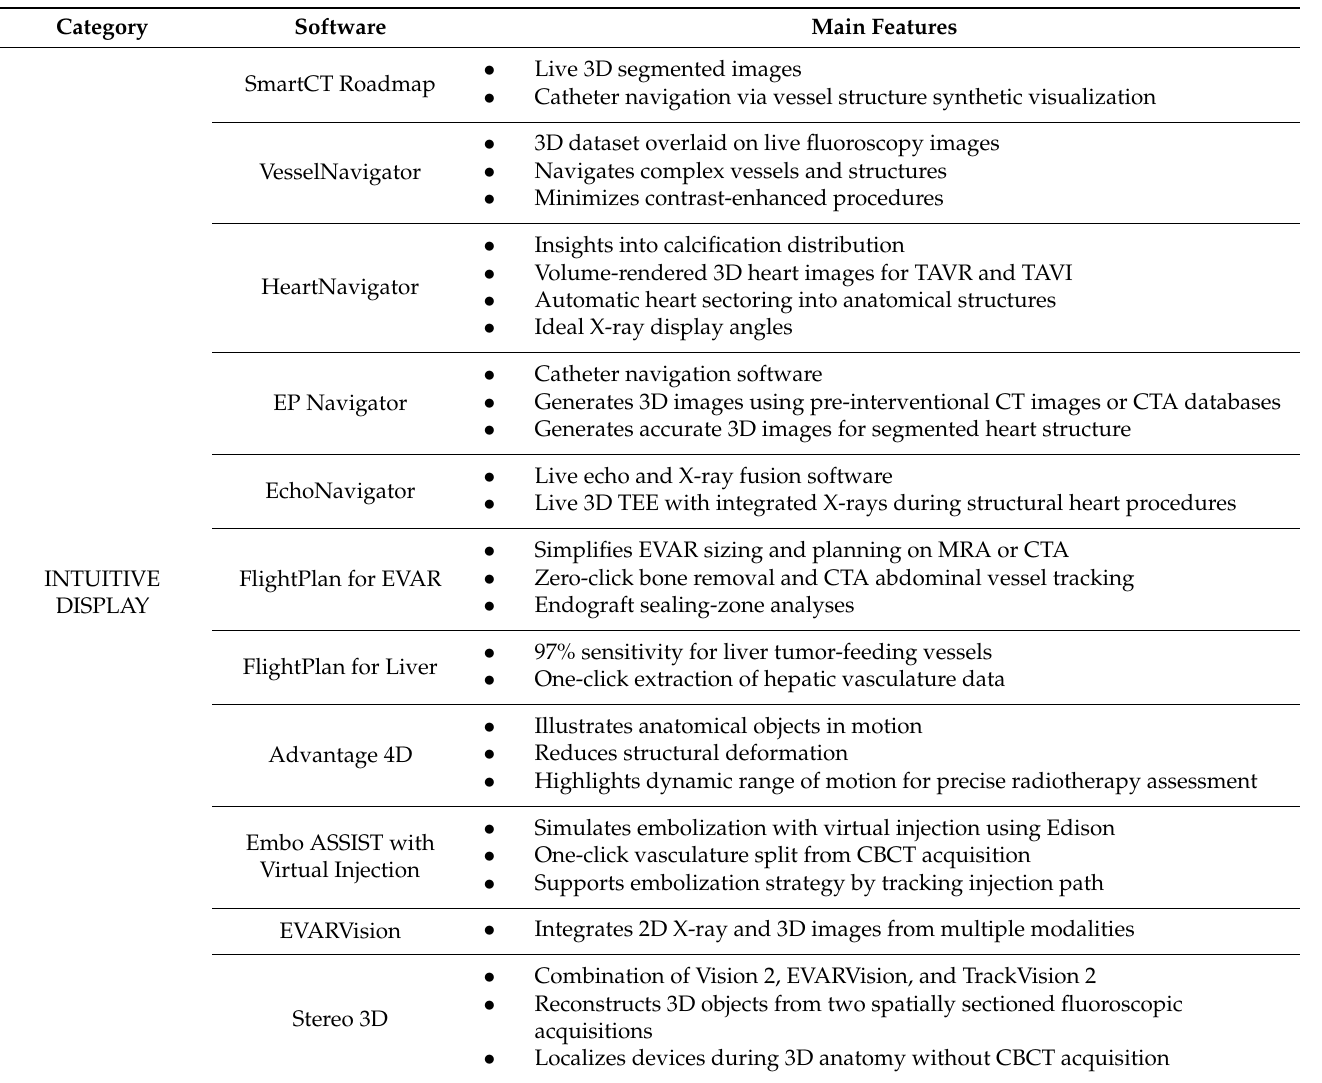
Table 4. Summary of commonly available (INTUITIVE DISPLAY) procedural software used in interventional